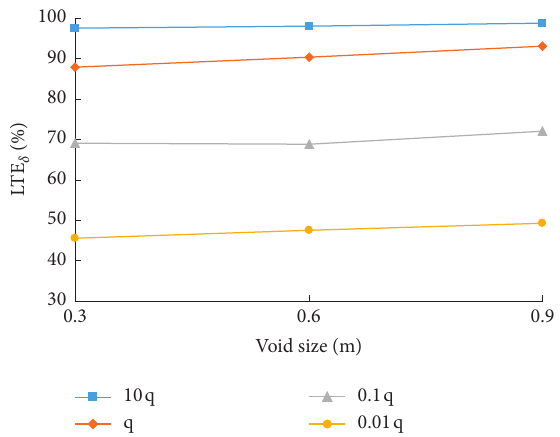
Figure 17: Relationship between void size and LTE in pavement with void underneath loaded and unloaded slab. δ Table 4: The stress of loaded slab with different void